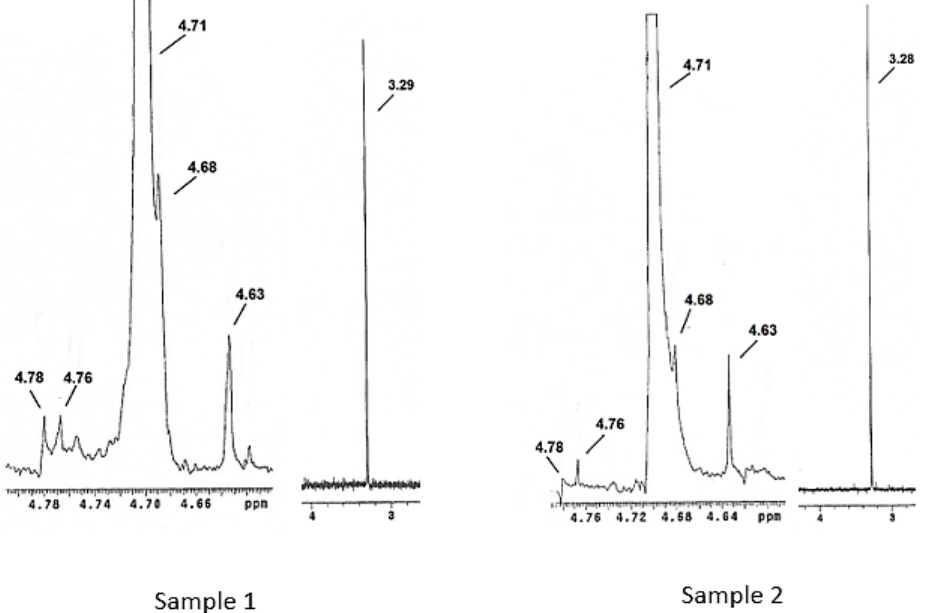
Figure 3. NMR spectra for Samples 1 and 2, showing the five signals corresponding to the chemical structure of the Vi antigen.